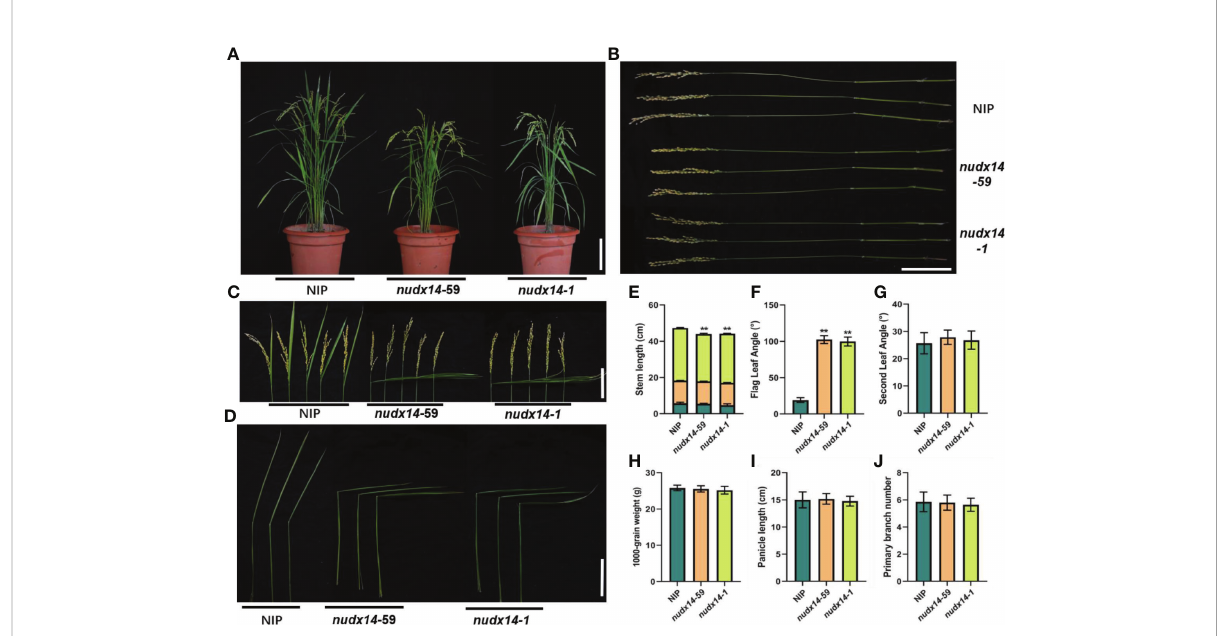
FIGURE 3 Effect of OsNUDX14 on the regulation of plant height and fl ag leaf angle. (A) Phenotype of the wild-type (WT) and nudx14 plants at the mature stage. Scar bar: 10 cm. (B) Internode length of WT and nudx14 plants. Scar bar: 10 cm. (C, D) leaf angle between WT and nudx14 plants at reproductive (C) and mature stage (D) . (E – J) Statistical analysis of stem length (E) , fl ag leaf angle (F) , second leaf angle (G) , 1,000-grain weight (H) , panicle length (I) , and primary branch number (J) . Signi fi cance is determined by two-sided Student ’ s t test, **P < 0.01.